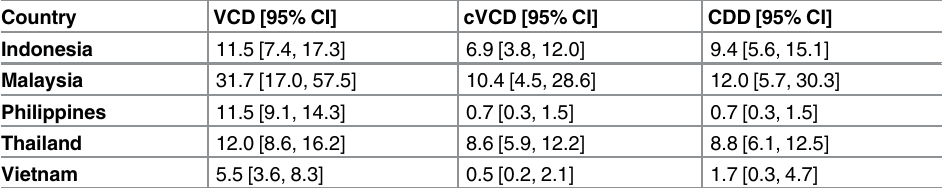
EFs varied according to case definitions. They were 5.5 − 31.7 for VCD, 0.5 − 10.4 for cVCD, and 0.7 − 12.0 for CDD (Table 3). These factors varied widely but tended to be lowest in Vietnam and highest in Malaysia. The incidence rates of dengue reported to the routine surveillance sys- tem appeared to be important determinants of EF: the highest EF (31.7) was observed in Malaysia (with the lowest reported IR) and the Philippines (with low EFs) reported the highest IRs in passive surveillance. Table 3. Expansion factors for VCD, cVCD, and CDD over the active phase of the CYD14 study.